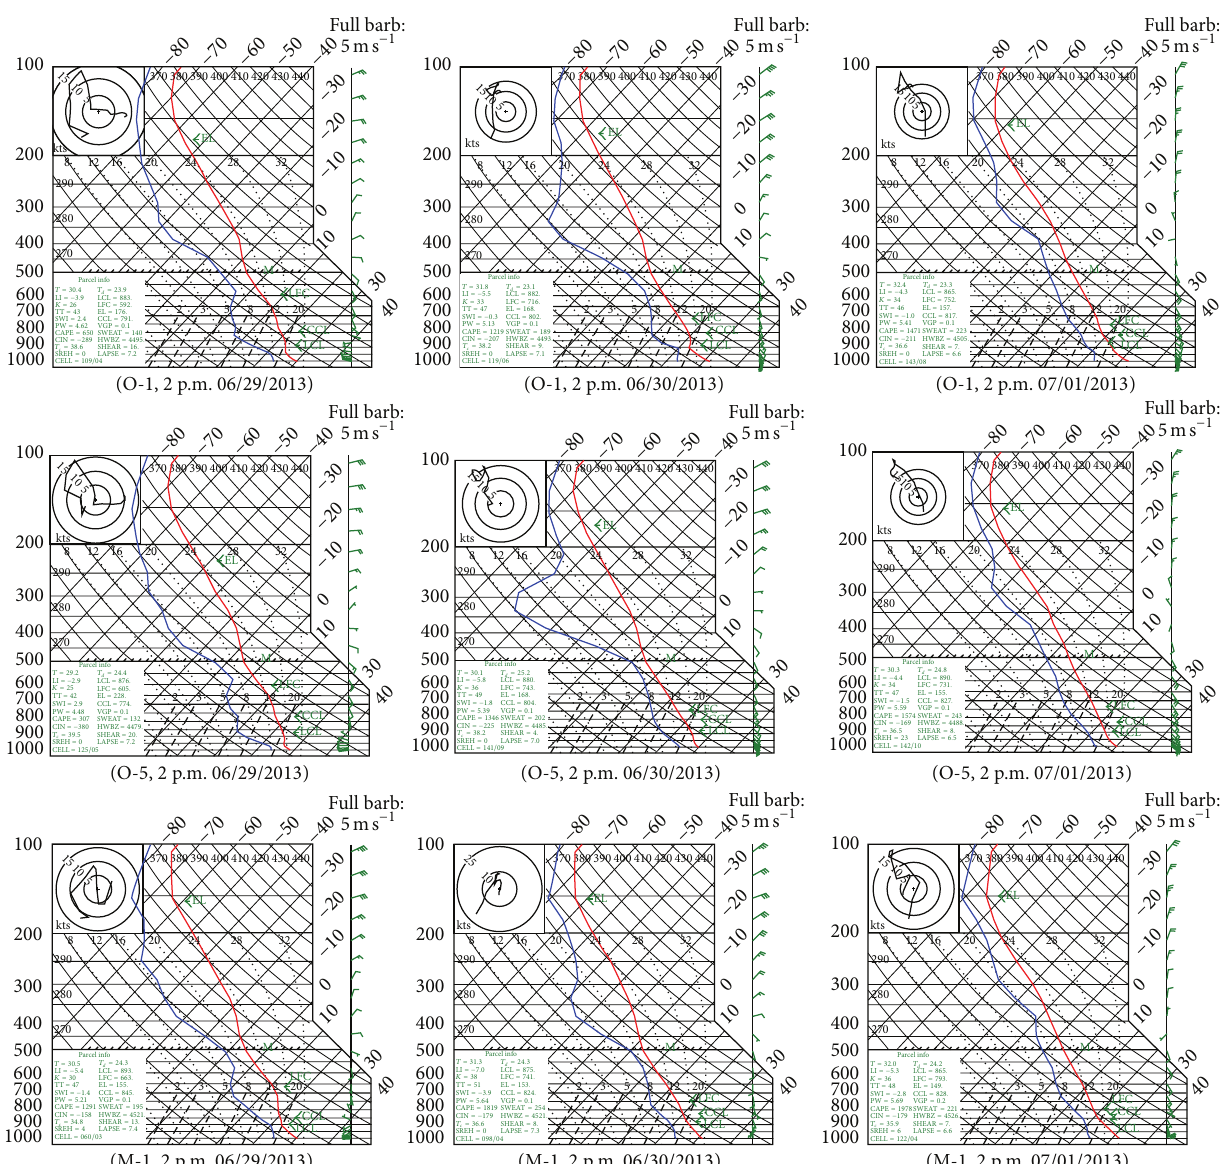
Figure 10: Skew-temperature diagram for Zuoying (O-1), Linyuan (O-5), and Meinong (M-1) stations (red line: temperature ( ∘ C), blue line: dew-point temperature ( ∘ C), and green vector: wind vector full barb = 5 m/s). concentration to be not so high in the afternoon of June 30 (see Figure 10